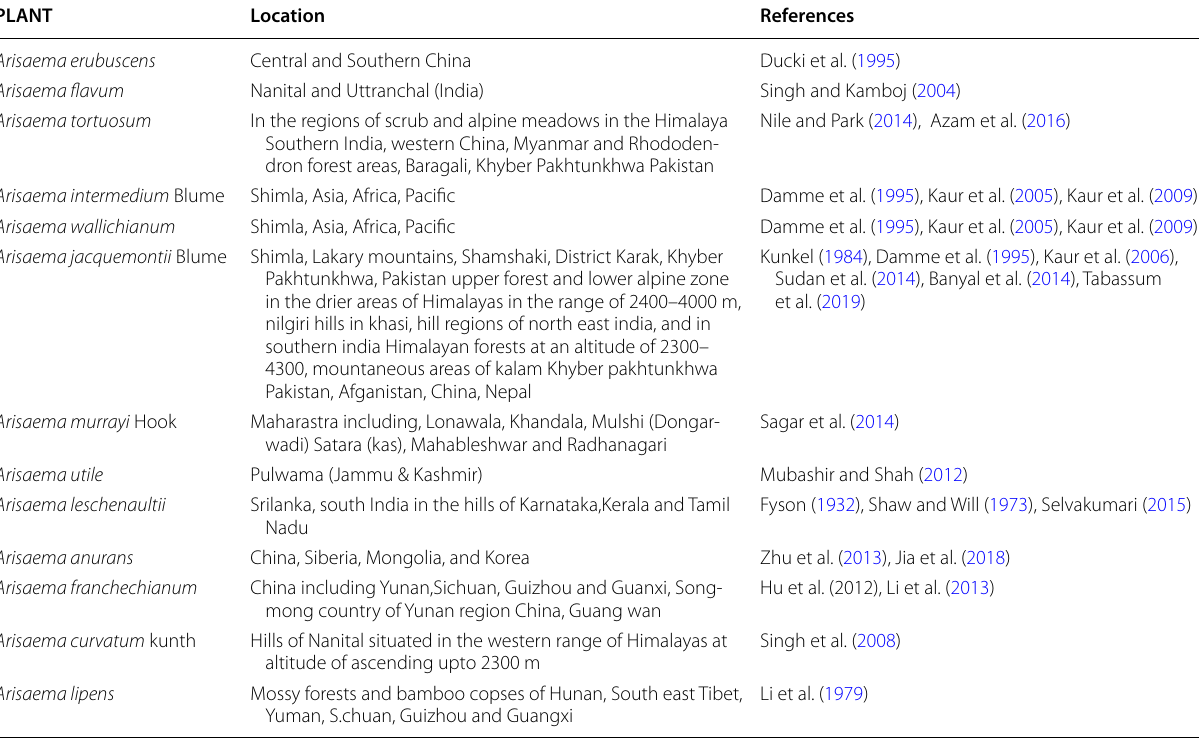
Table 1 Location of some of the species of Arisaema PLANT